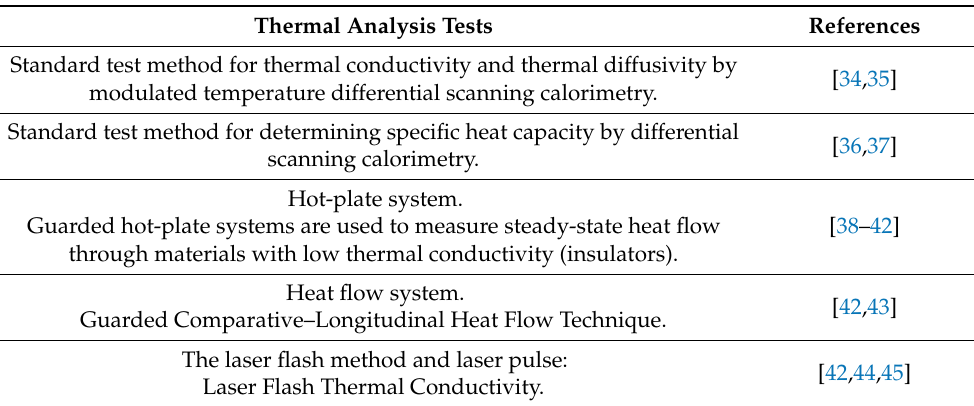
Table 1. Thermal analysis